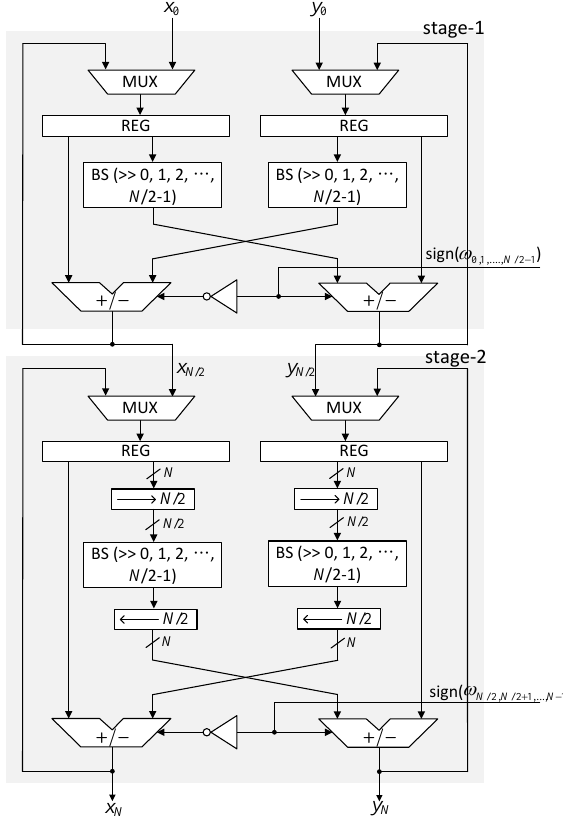
Figure 4. Structure of a 2-stage pipelined recursive cascaded CORDIC. −→ N /2 indicates a right-shift by ( N /2 ) bit locations. ←− N /2 indicates a sign-extension by ( N /2 )